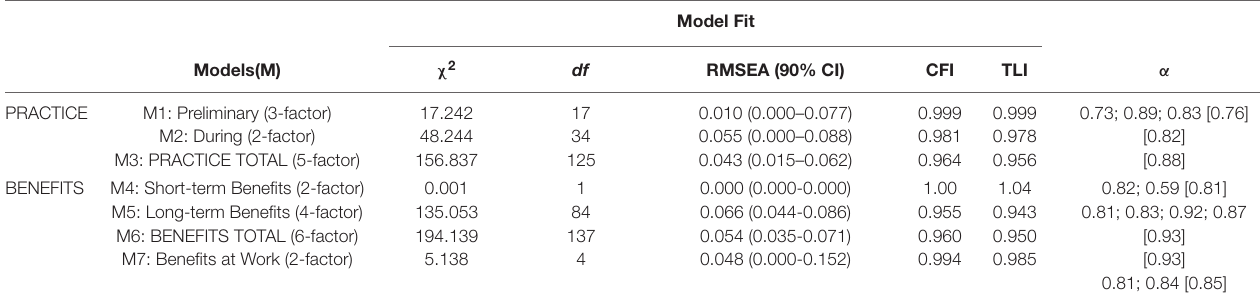
TABLE 1 | Results of tests for